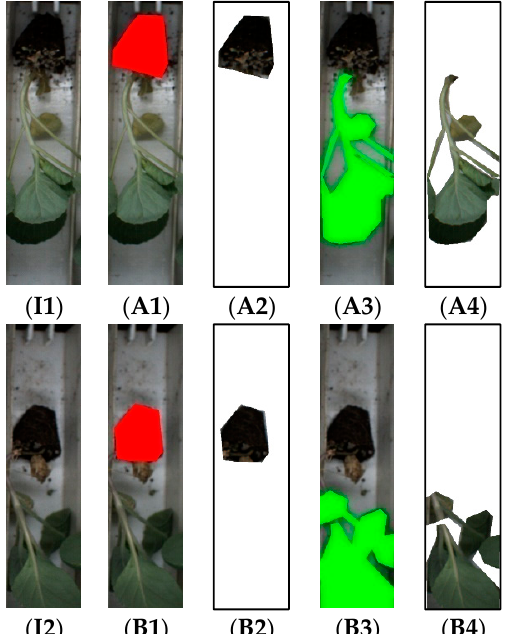
Figure 7. The labeled substrate and seedling region. ( I1 , I2 ) The original image; ( A1 , B1 ) the labeled substrate region; ( A2 , B2 ) the cropped substrate region; ( A3 , B3 ) the labeled seedling region; ( A4 , B4 ) the cropped seedling region.